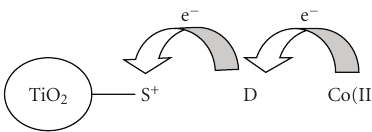
Figure 12: Sequence of electron transfer events involving the oxidized dye (S + ) the comediator (D) and the cobalt complex (Co(II)).